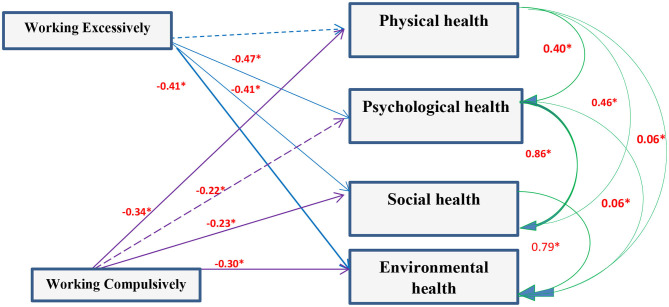
Path diagram of the model used for the whole group of subjects for work addiction scores and Quality of life (n = 1,080) (Multiple regression analysis using pathway analysis was applied). *significant.